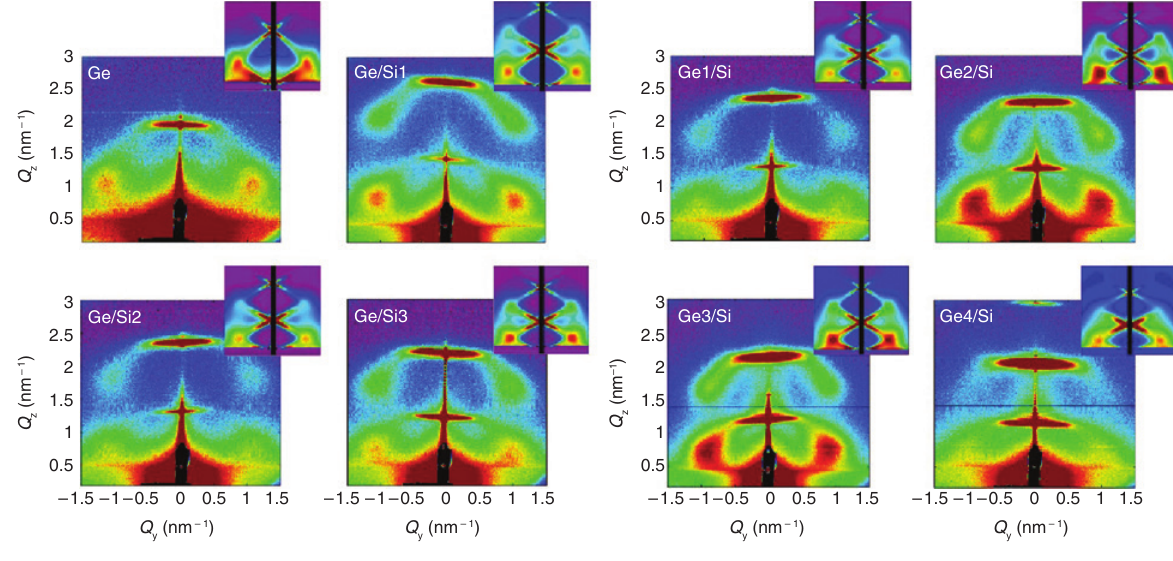
Figure 4: GISAXS maps of all studied samples. Insets show simulations obtained using the model that was explained in detail elsewhere